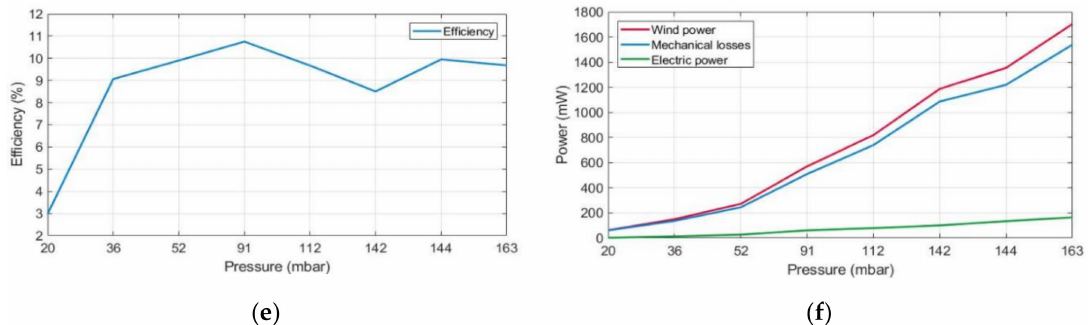
Figure 14. Generated values of electric power, mechanical losses and system e ffi ciency values from 3 m / s to 10 m / s; from10 mbar to 163 mbar with 27 Ω ( a , b ), 11 Ω ( c , d ) and 100 Ω load ( e , f ). ( a ) System e ffi ciency (27 Ω ). ( b ) Power di ff erences / losses through di ff erent steps of the mini wind harvester (27 Ω ). ( c ) System e ffi ciency (11 Ω ). ( d ) Power di ff erences / losses through di ff erent steps of the mini wind harvester (11 Ω ). ( e ) System e ffi ciency (100 Ω ). ( f ) Power di ff erences / losses through di ff erent steps of the mini wind harvester (100 Ω ).